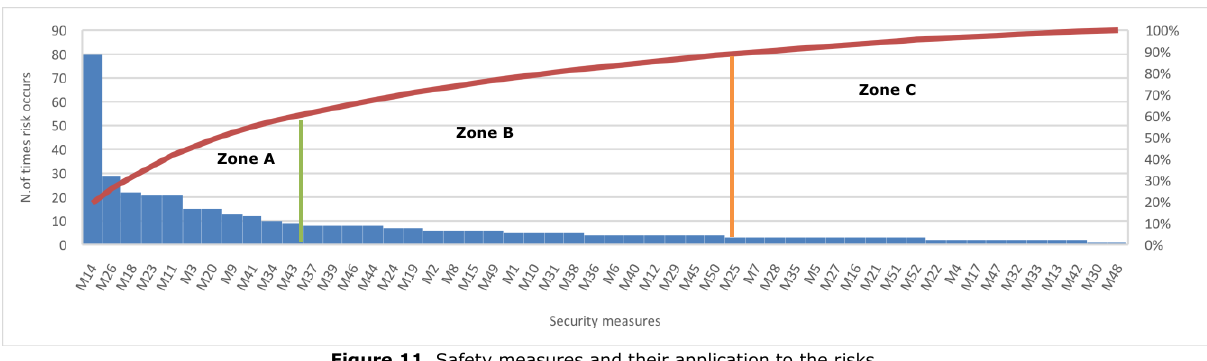
Figure 11. Safety measures and their application to the